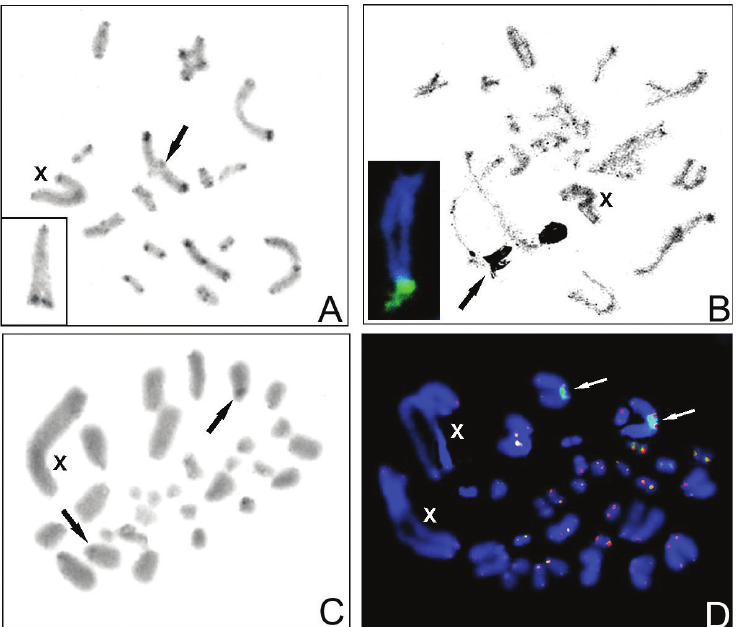
Fig. 9. Chromosomes of: A, B . Paraplangia sinespeculo and; C, D . Orophus cf. tessellatus stained using different techniques: C-banding ( A , C ), silver staining ( B ), and FISH with both 18S rDNA (green) and telomeric DNA (red) probes ( B – left corner and D ). Diakinesis and the insert in the left corner mitotic large chromosome ( A ), diplotene and FISH with 18S rDNA in the left corner mitotic chromo- some ( B ): arrows and the insert chromosome demonstrated distally located thin C-band and single NOR coincide with cluster of 18S rDNA on the first pair of autosome. Arrows in spermatogonial ( C ) and female metaphases ( D ) indicate near paracentromeric located C-bands and 18S rDNA loci on the fourth pair of chromosomes. X indicates sex